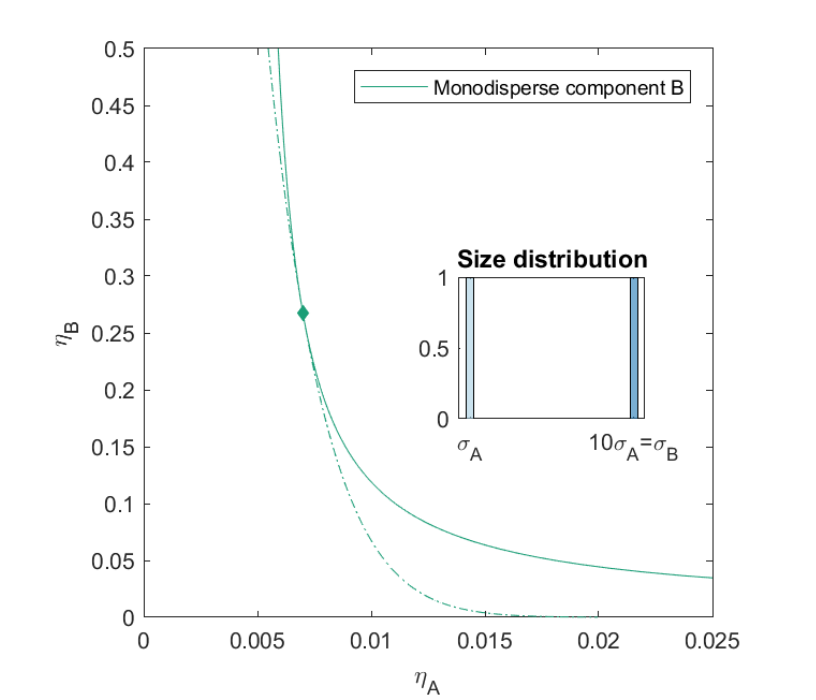
Figure 2. Phase diagram for monodisperse binary (component A and B ) additive hard sphere mixture with size ratio q = σ A / σ B = 1/10, plotted as a function of the partial packing fractions, η A and η B . The spinodal ( solid line ) and binodal ( dashed line ) meet each other at the critical point